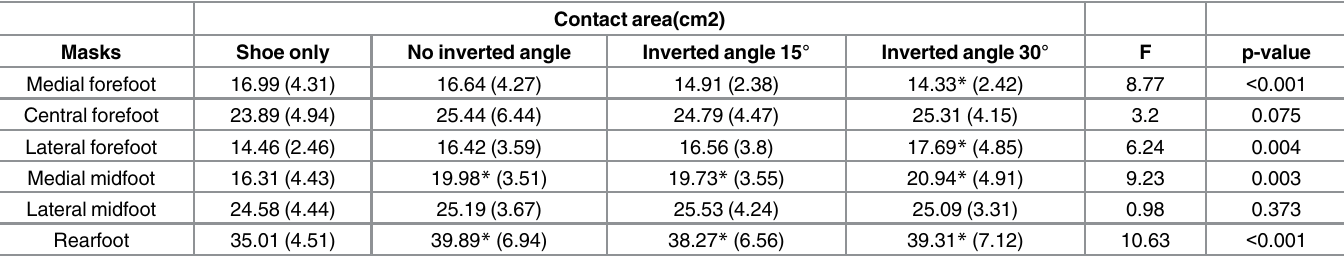
Table 4. Contact areas of the 6 mask areas in each foot orthotic